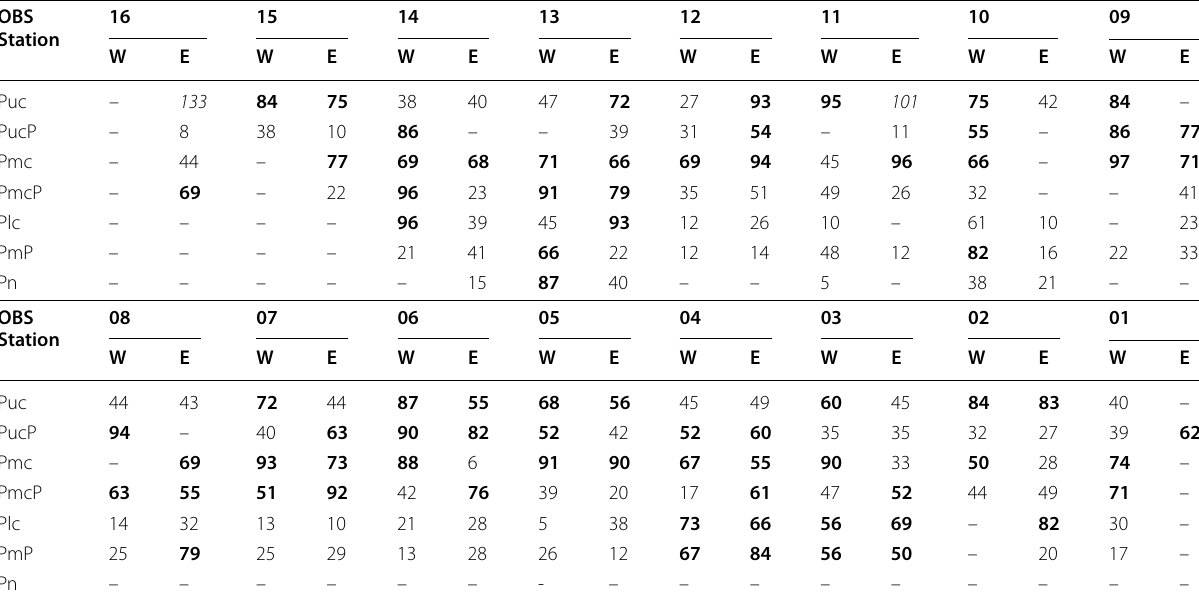
Travel-time errors of 50–100 ms and greater than 100 ms are denoted by bold and italics emphasis, respectively